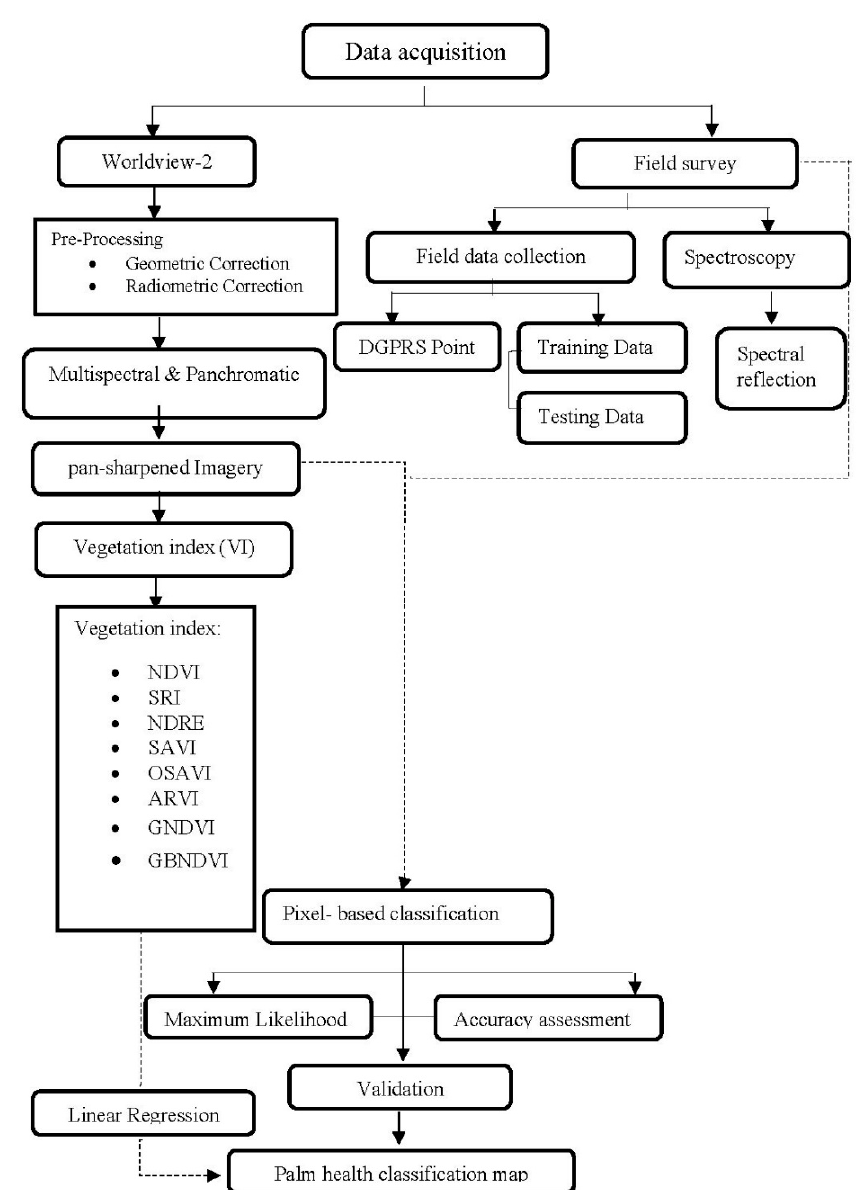
Figure 4. Flowchart of the methodology followed in the current study.